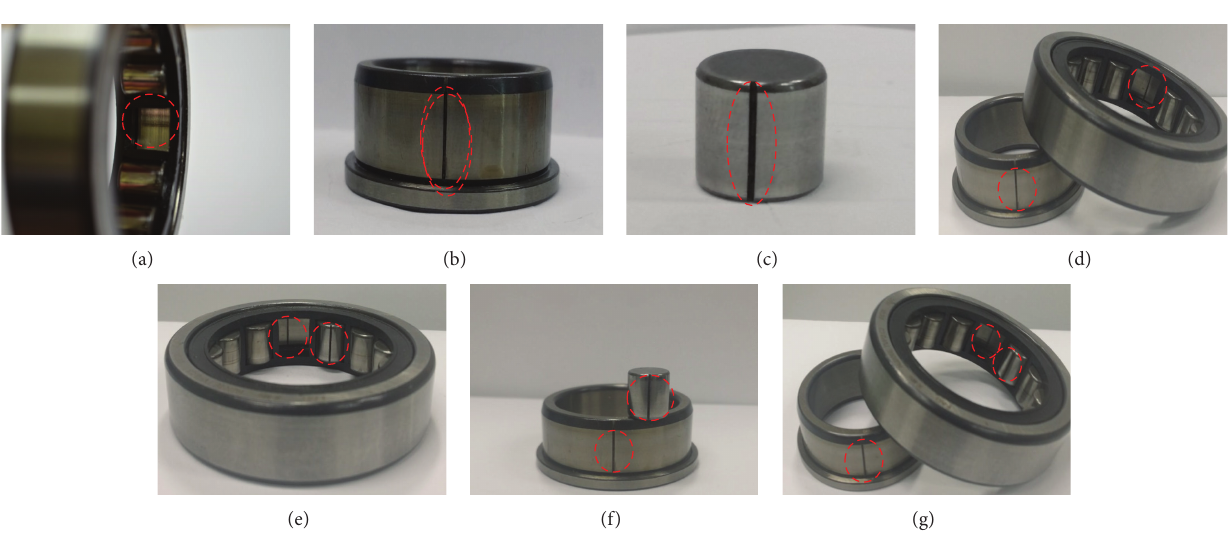
Figure 2: Single and multiple-combined bearing defects. (a) CRBCO, (b) CRBCI, (c) CRBCR, (d) CRBCOI, (e) CRBCOR, (f) CRBCIR, and (g) CRBCOIR.